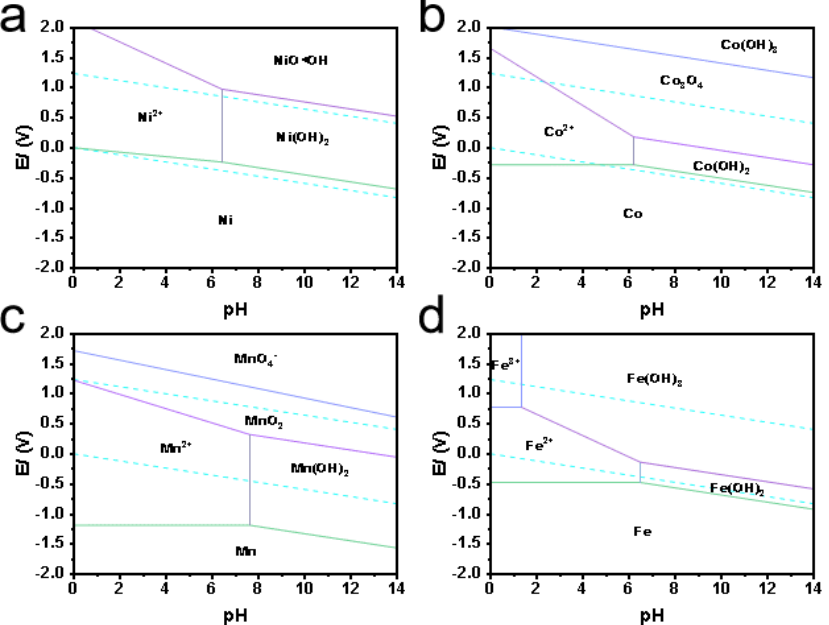
Figure 5. Eh － pH diagram of ( a ) Ni － H 2 O, ( b ) Co － H 2 O, ( c ) Mn － H 2 O, ( d ) Fe － H 2 O system at Figure 5. Eh–pH diagram of ( a ) Ni–H 2 O, ( b ) Co–H 2 O, ( c ) Mn–H 2 O, ( d ) Fe–H 2 O system at standard conditions (T = 298 K, p = 1 atm and α = 1 M) as calculated by HSC 6.0 software.